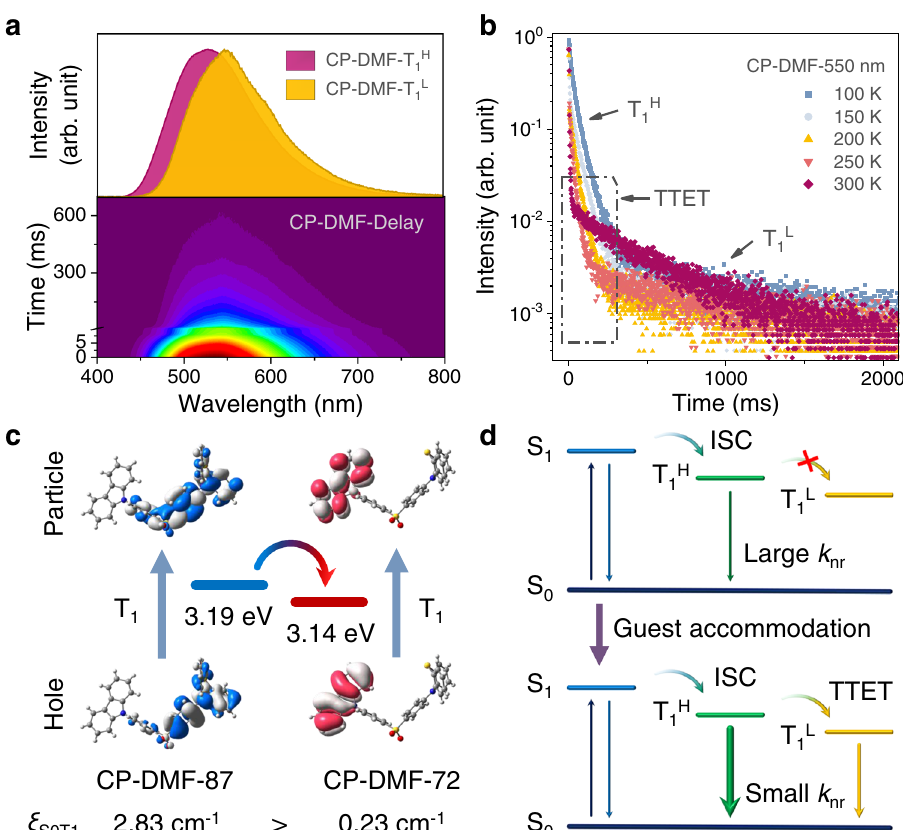
Fig. 5 | Excited state process investigation of dynamic URTP feature. a Time- resolvedemissionspectraofCP-DMFcrystalsunderambientconditions.Theupper inset shows the phosphorescence spectra at delay times of 8ms (pink) and 80ms (yellow),respectively. b Temperature-dependentlifetimedecaypro fi lesofCP-DMF crystals measured at 550nm wavelength with a 355nm spectral-LED source under vacuumconditions. c Naturaltransitionorbitals(NTOs)contributingtothelowest-